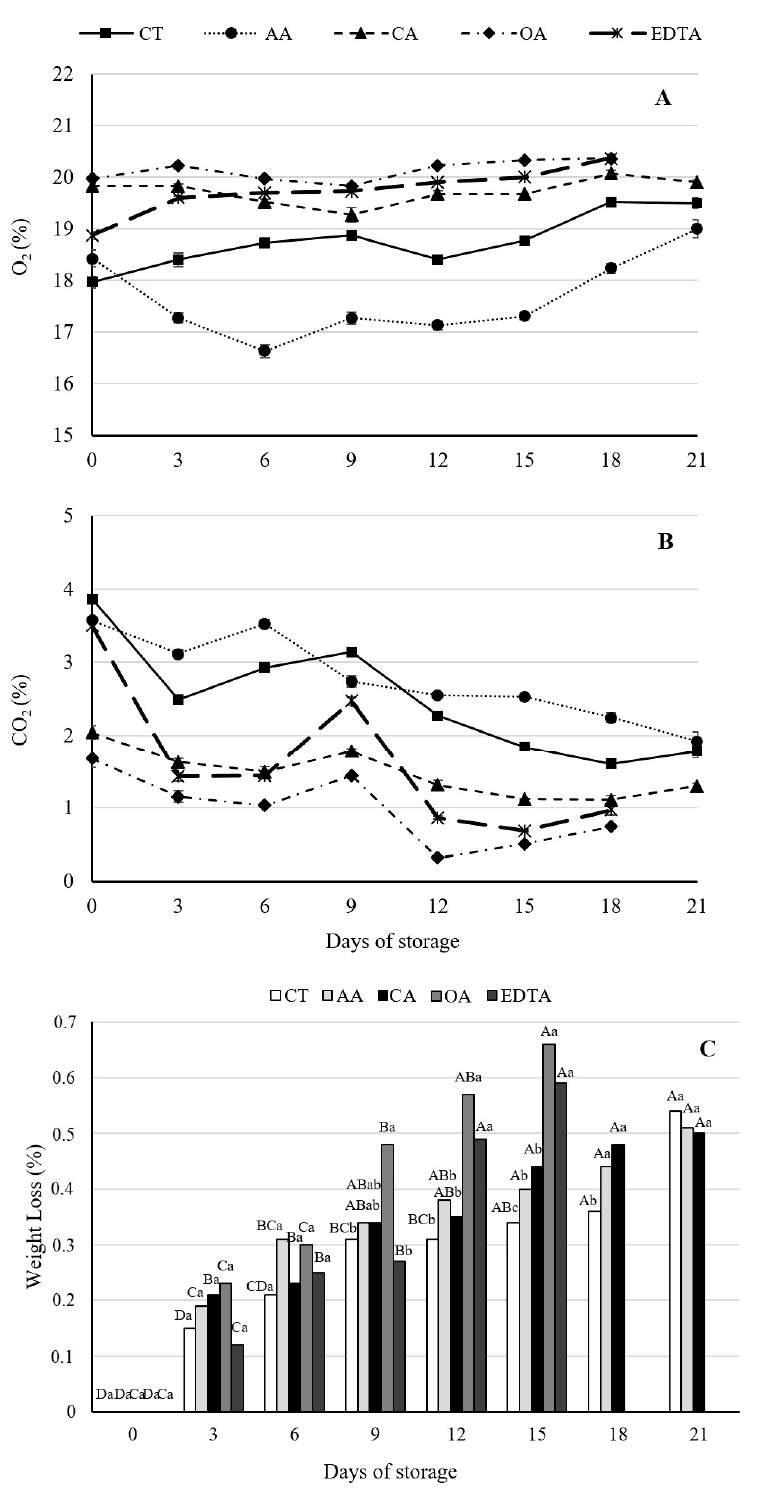
Figure 4. Concentration of oxygen ( A ) and carbon dioxide ( B ) within the packaging and weight loss (%) ( C ) of minimally-processed escarole with antioxidants and stored at 0 °C and 90–95% relative humidity for 21 days. Vertical bars represent the standard error of the mean ( n = 3). The means represent the average of 3 replicates. Means followed by different uppercase letters within each day of storage and lowercase letters between treatments differ from each other by Tukey’s test ( P ≤ 0.01). CT: control; AA: 1% ascorbic acid; CA: 1% citric acid; OA: 1% oxalic acid; and 2% EDTA: ethylenediaminetetraacetic acid.